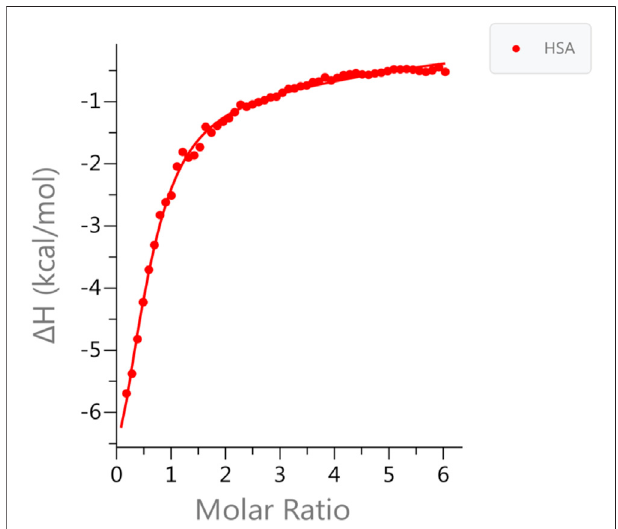
FIGURE 1 | Measurements of Zn(II) binding af fi nity to HSA in the absence of FA. ITC data for Zn(II) binding to HSA in the absence of FA. The datawas fi ttedtotwosetofbindingsites.Onehighaf fi nitysite(MBS-A);K D1 = 5.43 ± 0.5 µM and up to seven secondary low af fi nity sites K D2 = 80 ± 5 µM was